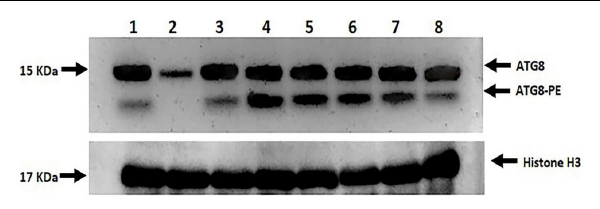
FIGURE 11 | Immunoblot analysis of ATG8 and ATG8-PE in melatonin primed and unprimed drought-sensitive (L-799) and -tolerant (Suraj) varieties under drought stress or optimal conditions. Lane 1- L-799, control; Lane 2- L-799, stressed; Lane 3- L-799, primed control; Lane 4- L-799, primed stressed; Lane 5- Suraj, control; Lane 6- Suraj, stressed; Lane 7- Suraj, primed control; and Lane 8- Suraj, primed